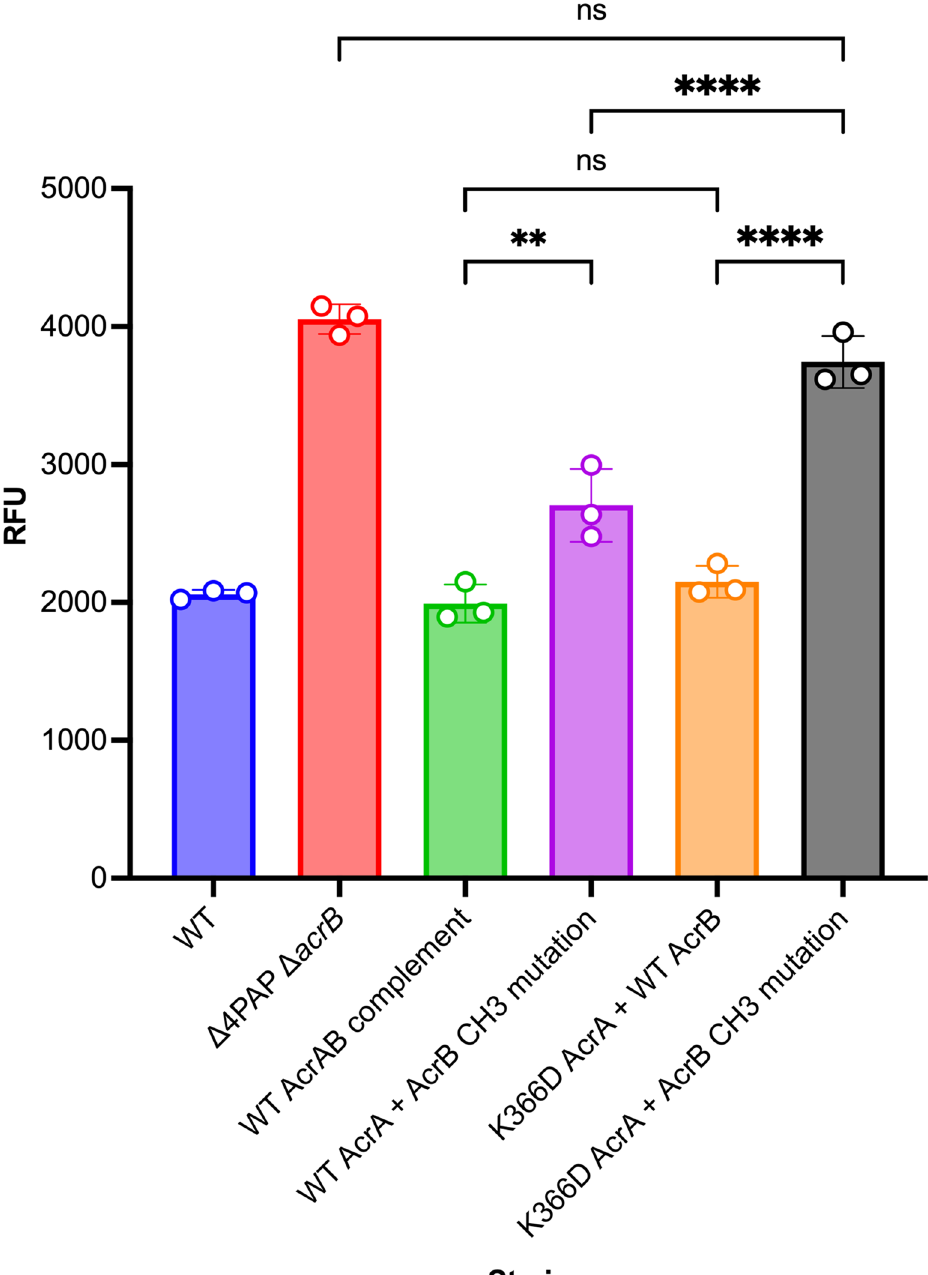
Figure 7. Accumulation of ethidium bromide in the Salmonella Typhimurium SL1344 Δ4PAP Δ acrB strain complemented with K366D AcrA and AcrB channel 3 (A33W T37W N298W AcrB) mutation. The data shown are the mean of three biological replicates showing maximum RFU values after 30 min of ethidium bromide exposure ± standard deviation. Data were analysed by one-way ANOVA and corrected for multiple comparisons using Tukey’s test. Strains with significantly different ethidium bromide accumulation are indicated with ** ( P ≤ 0.01) or **** ( P ≤ 0.0001). ns, not